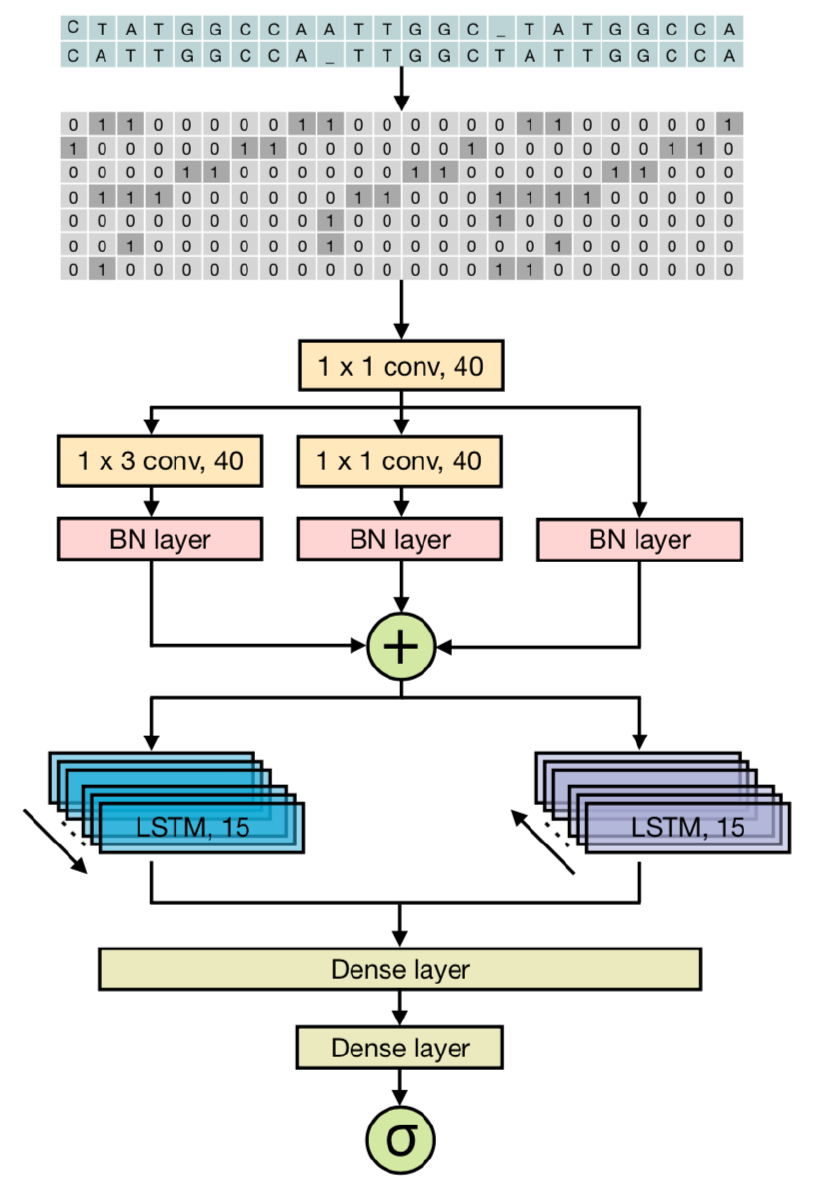
Figure 3. Overview of R-CRISPR. The input on- and off-target sequence pairs is represented into a 7 × length (i.e., length represents the length of gRNA-target sequences) binary matrix as the input of the feature extraction layer. The feature extraction layer contains 40 convolutional kernels and 40 modified RepVGG modules composed of a 1 × 3 convolutional kernel, a 1 × 1 convolutional kernel, and an identity branch. The output of the feature extraction layer is then passed to the bi-directional recurrent layers, each direction is based on 15 LSTM units, to learn sequential patterns of the feature matrix. Followed by the recurrent layer, there are two dense layers with sigmoid as the activation function for final